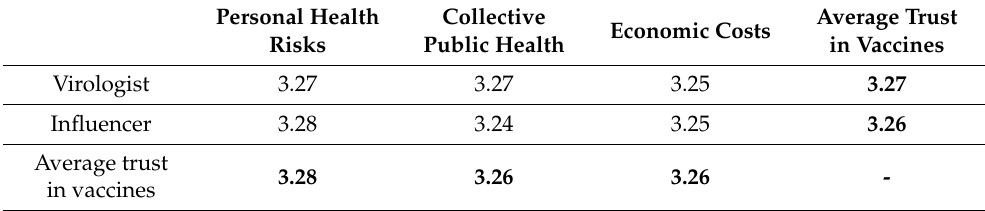
Table 4. Overall trust in vaccines.